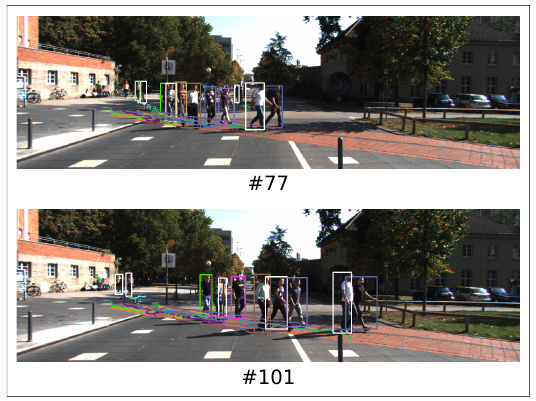
Figure 1. An exemplary tracking results of our tracker. The generated pedestrian trajectories are back-projected to image space at two different